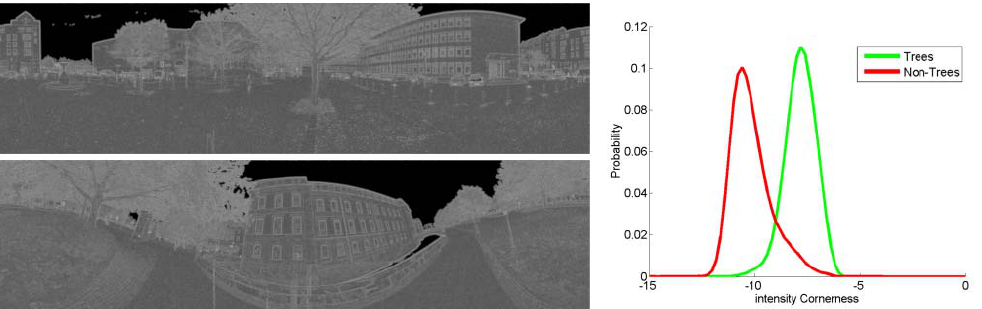
Figure 8. Intensity cornerness values, and their tree/non-tree